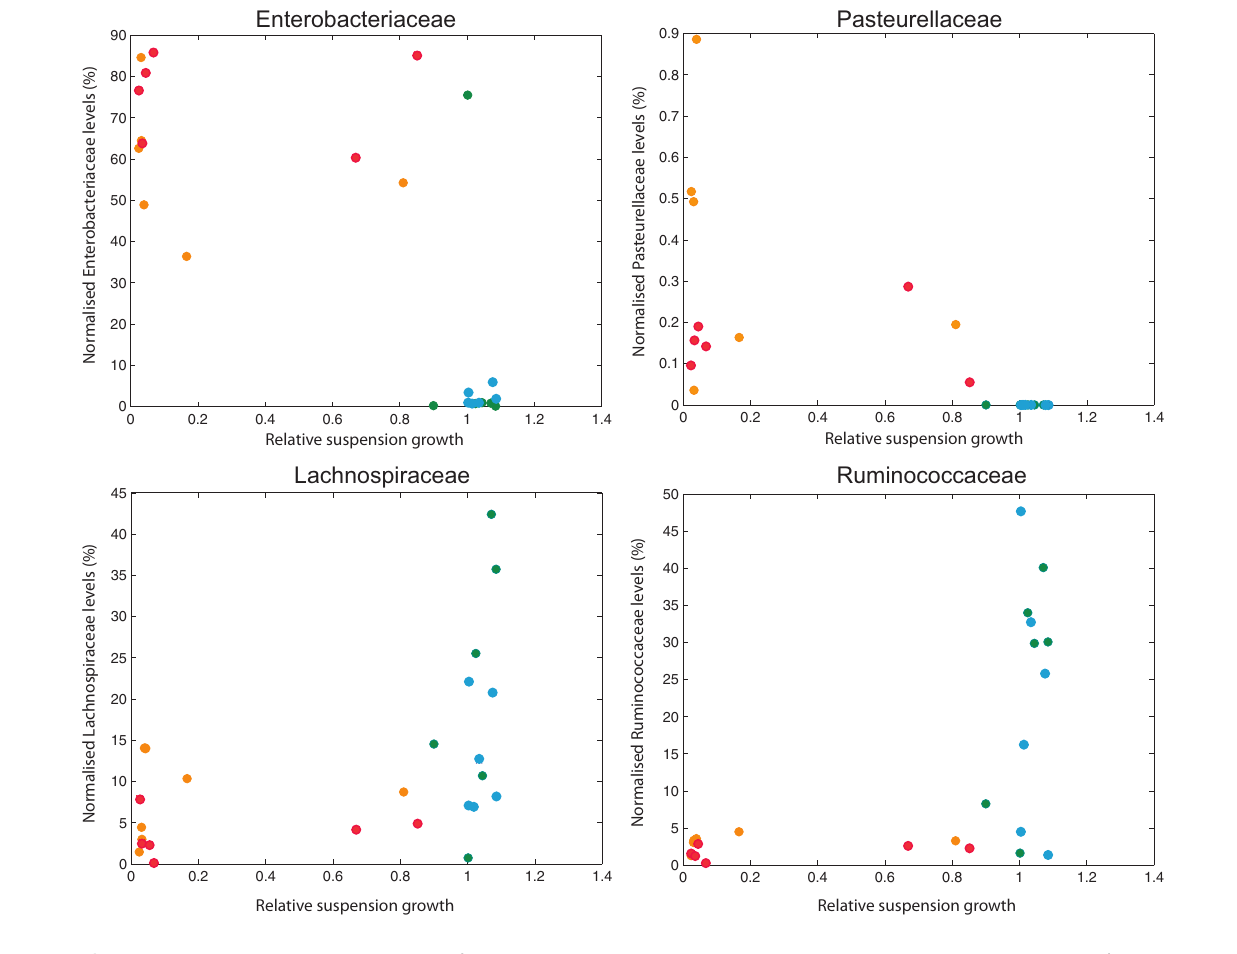
FIGURE 4 | Scatter plots of normalized bacterial levels ( Enterobacteriaceae , Pasteurellaceae , Lachnospiraceae, and Ruminococcaceae) and relative suspension growth of L5178Y mouse lymphoblastoid cells exposed to fecal water extracts of six sham and six RYGB rats at weeks 2 and 8 post intervention. Orange: RYGB-2weeks post op; Red: RYGB-8weeks post op; Green: Sham-2weeks post op; Blue: Sham-8weeks post